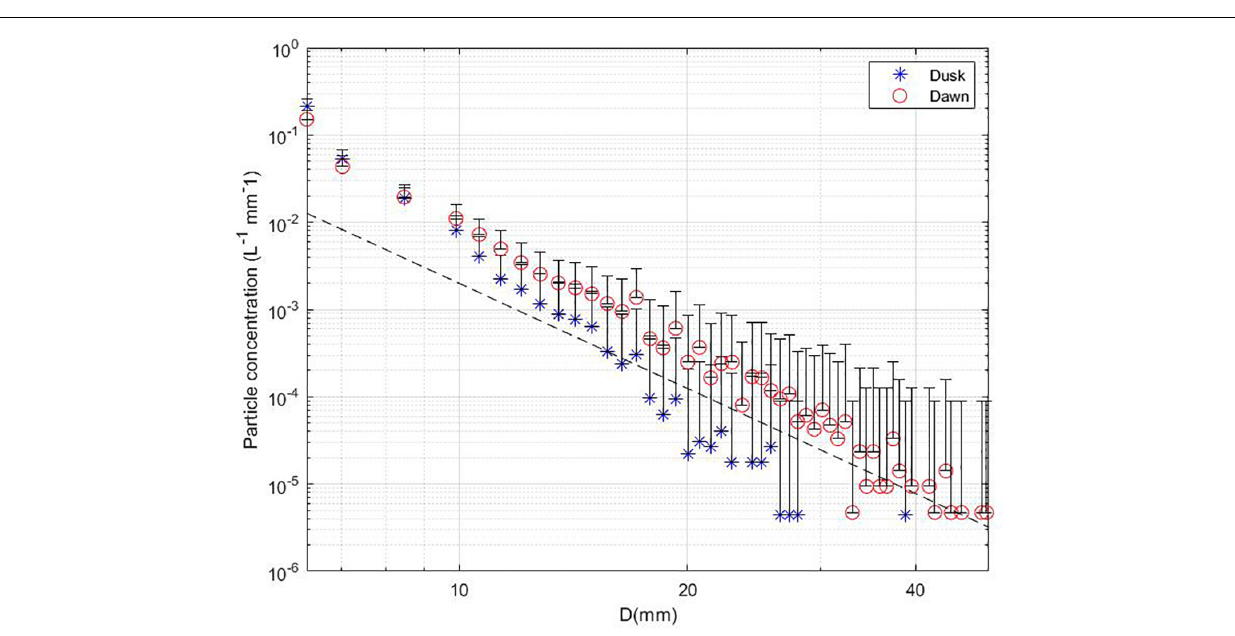
Z -score is an indicator of significance, where z < − 3 corresponds to significant ( p < 0.001) particle clustering and z > 3 to significant dispersion. The spatial distribution of particles in each scan was compared to a random uniform distribution of